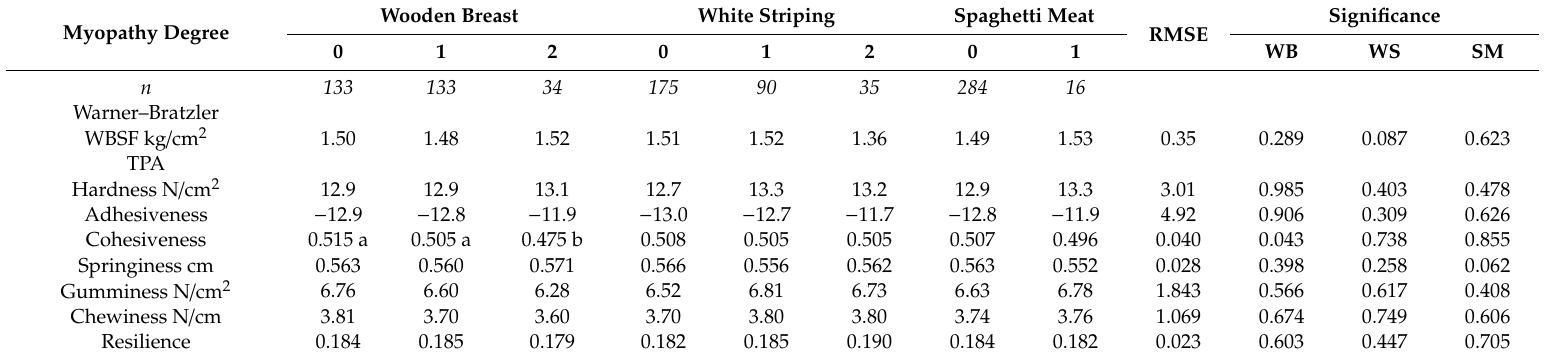
Table 5. Texture of broiler cooked breast with di ff erent degree of myopathies by di ff erent texture